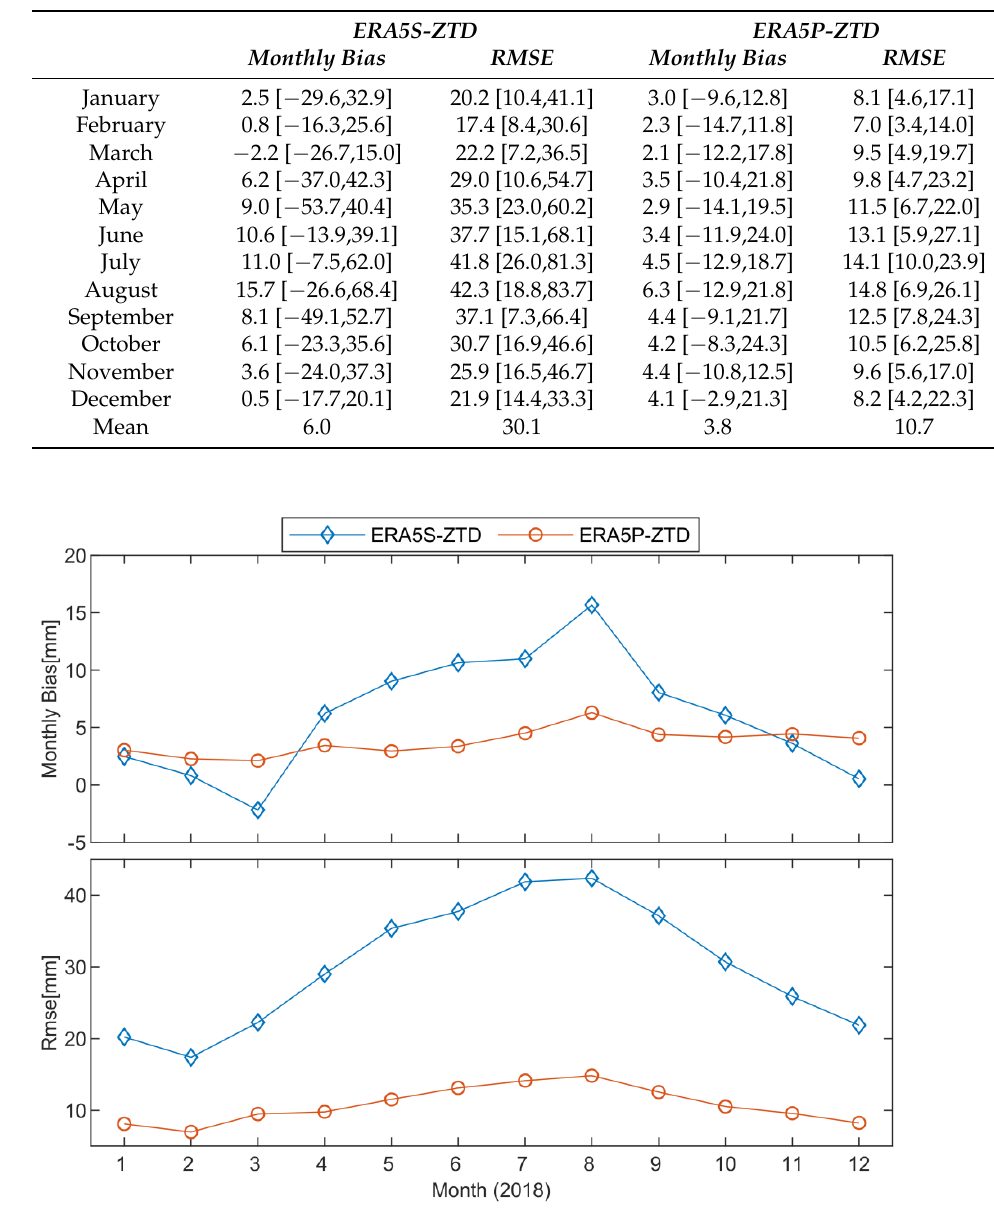
Table 2. Monthly bias and RMSE of the ERA5S-ZTD and ERA5P-ZTD by comparison with the IGS- ZTD at all available stations. Values in brackets refer to the monthly minimal and maximal value for all available stations. Unit is millimeter.